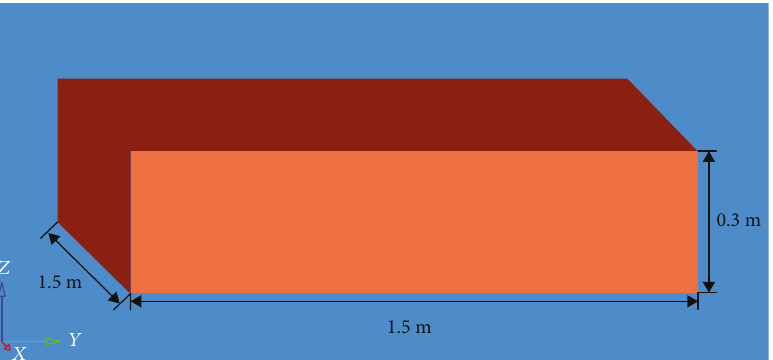
Figure 10: The model of a dielectric slab.